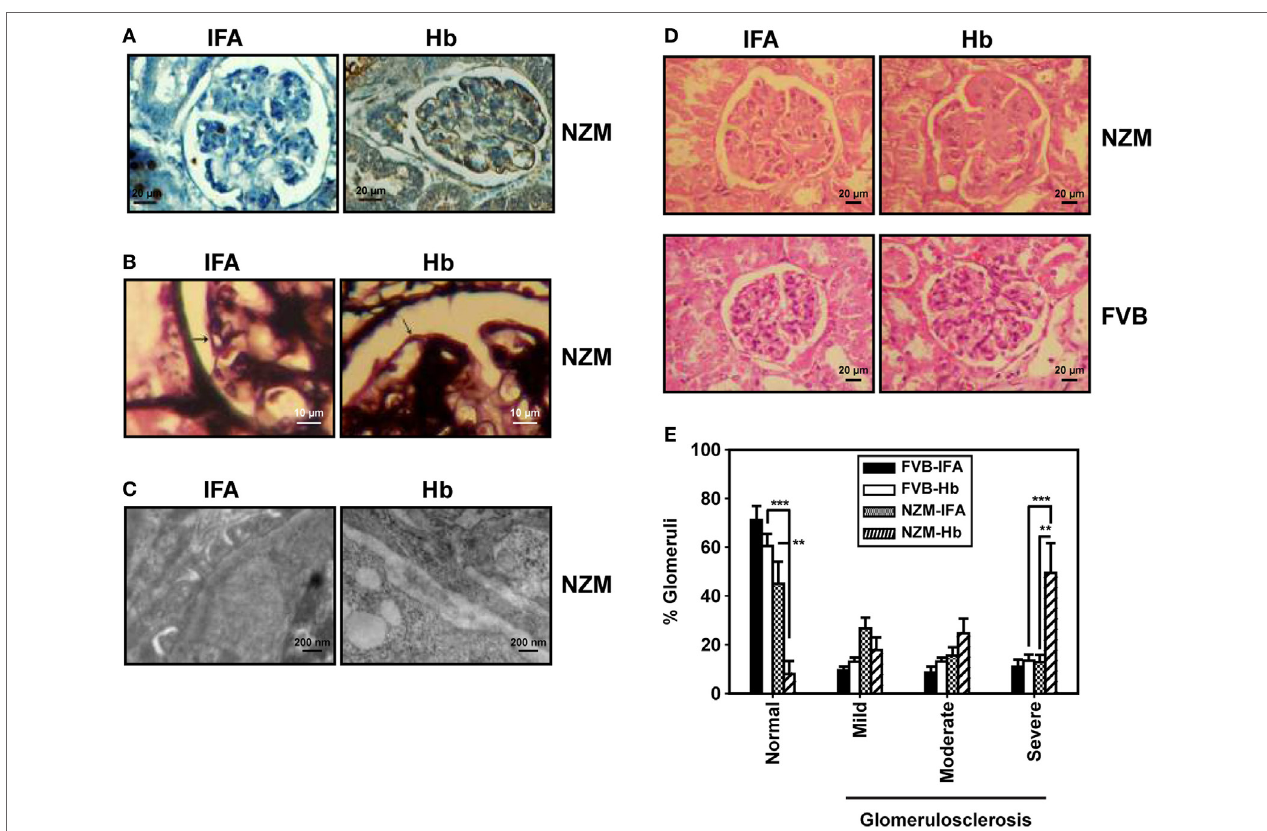
FigUre 7 | Histological analysis of kidneys from FVB and NZM mice. (a) Representative photomicrographs depicting reactivity of anti-C3 antibodies toward glomerulii of incomplete Freund’s adjuvant (IFA)- and hemoglobin (Hb)-immunized NZM mice 16 weeks after the initiation of immunization (40 × ; scale bars: 20 µm). (B) Representative photomicrographs depicting methenamine silver staining of glomerulii sections from IFA- and Hb- immunized NZM mice 16 weeks after the initiation of immunization. Basement membranes have been indicated by arrows (40 × ; scale bars: 10 µm). (c) Representative electron micrographs depicting kidneys from IFA- and Hb-immunized NZM mice 16 weeks after the initiation of immunization (12,000 × ; scale bars: 200 nm). (D) Representative photomicrographs depicting hematoxylin- and eosin-staining of kidney sections from IFA- and Hb-immunized FVB and NZM mice 16 weeks after the initiation of immunization (40 × ; scale bars: 20 µm). (e) Quantitative analysis (at 16 weeks after the initiation of immunization) of glomerulosclerosis (categorized as “mild,” “moderate,” or “severe”) in IFA- and Hb-immunized FVB and NZM mice ( n = 8). Data represent mean ± SEM (** p < 0.005, *** p <